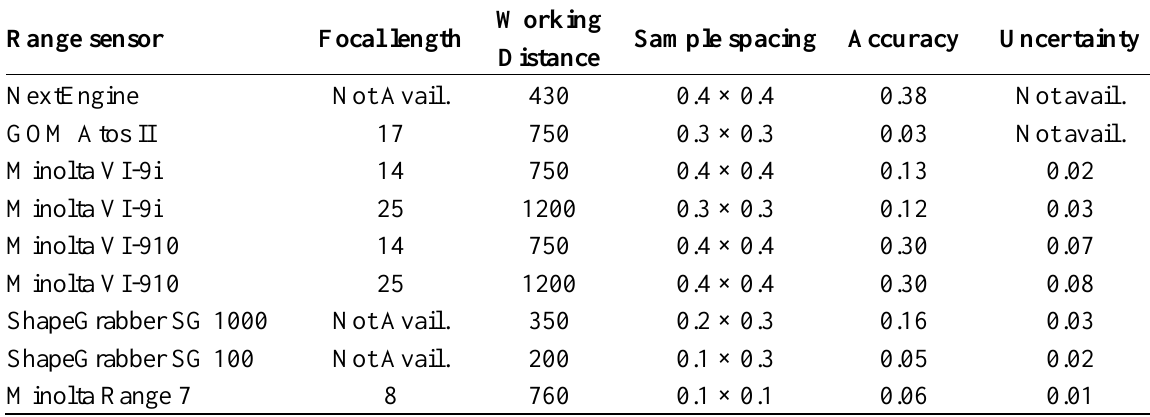
Table 1. Nominal characteristics of the instruments used for the tests, at the chosen working distances, available from the producers data sheets (all values are in